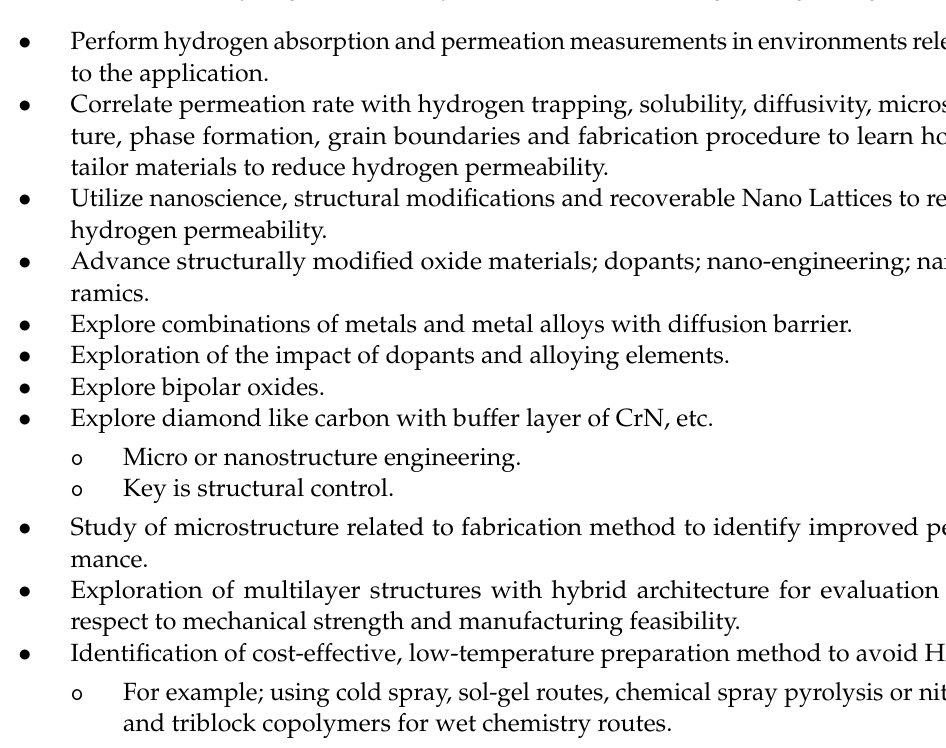
Figure 4. Advanced Hydrogen Barriers; key materials and material engineering strategies .